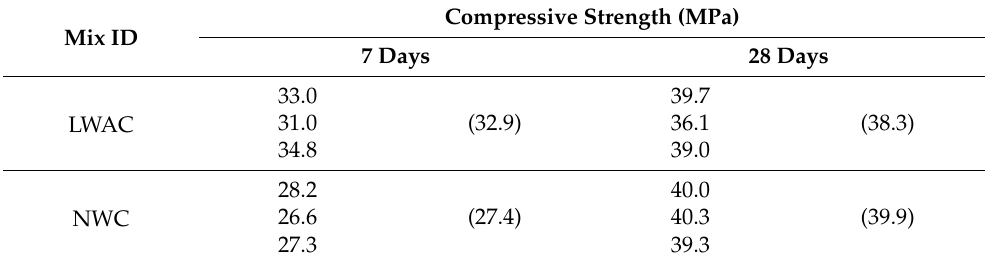
Table 5. Compressive strength of the concrete.